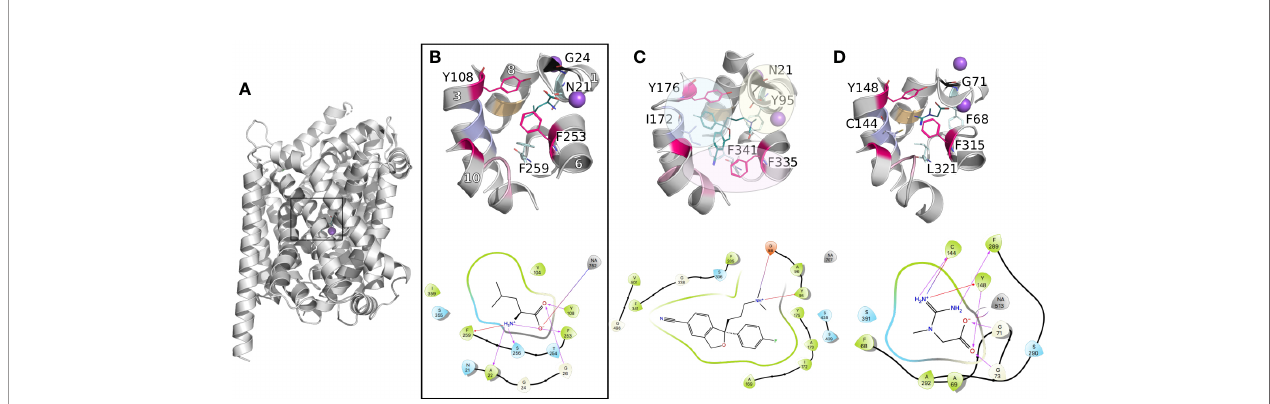
FIGURE 2 | Conserved binding site organization of the SLC6 family. Binding sites comparisons between LeuT and representative human members of the MATs and GATs subgroups. The proteins are shown in gray cartoons with Na + and Cl − ions as purple and green spheres, respectively. The key amino acids constituting the binding site are labeled and shown in lines with the following color code: conserved gates are shown in pink; residues anchoring the ligands in black and cyan (TM1 and 6); amino acids involved in substrates speci fi cities are shown in light pink, purple, and orange (TM10, 3, and 8 respectively). Finally, the bound ligands are shown in teal lines. For each complex, the 2D representation are shown in the bottom panel. The 3D representations have been generated with Pymol (Schrodinger), and the 2D with Maestro (Schrödinger, 2019). (A) Three-dimensional structure of LeuT (PDB ID 2A65 (Yamashita et al., 2005)) bound to Leucine. The black square locates the binding site. (B) A close up of LeuT binding site is shown, with the helices numbers indicated in white. (C) Binding site of the crystallographic structure of hSERT (PDB ID 5I73 (Coleman et al., 2016b)) bound to escitalopram. The subpockets A, B, C as reported in literature (Navratna and Gouaux, 2019; Cheng and Bahar, 2019) for the monoamine subgroup are represented with yellow, blue, and pink spheres, respectively. (D) Binding site of a homology model of the creatine transporter (Colas et al.,